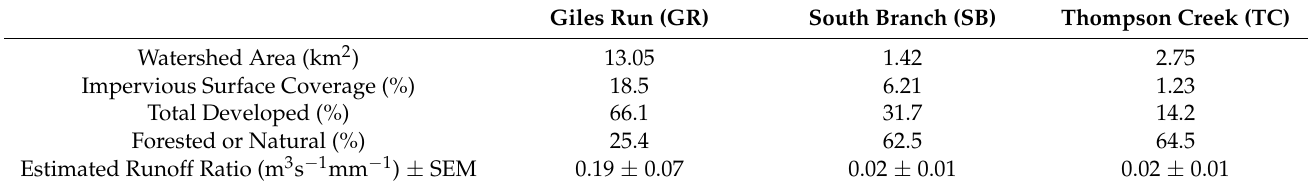
Table 1. Watershed Characteristics for Each Stream. SEM = Standard error of the mean.